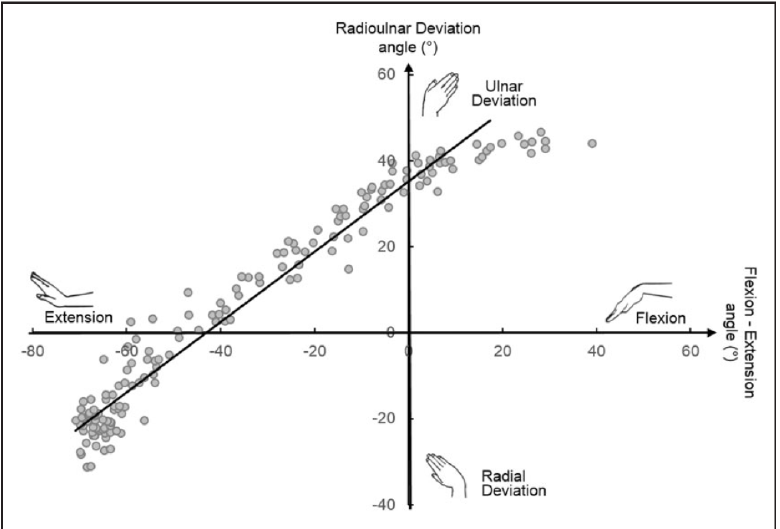
Figure 6. Theil − Sen estimator of the DTM plane (solid line) for the optical motion capture data of a single representative subject. Reprinted/adapted with permission from Vardakastani et al. [36], published by SAGE, Journal of Hand Surgery (European Volume),